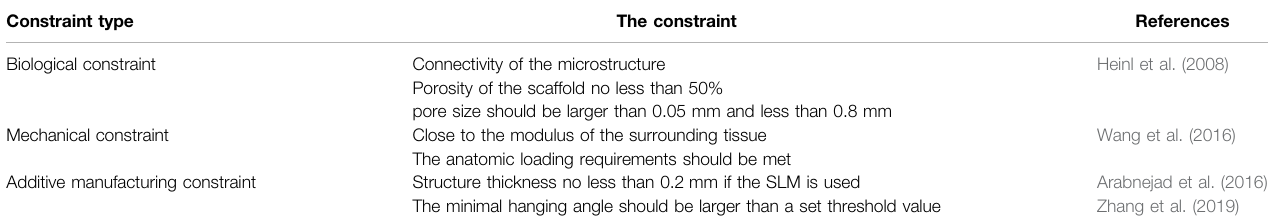
TABLE 5 | The constraints required to be considered in the design of the bone